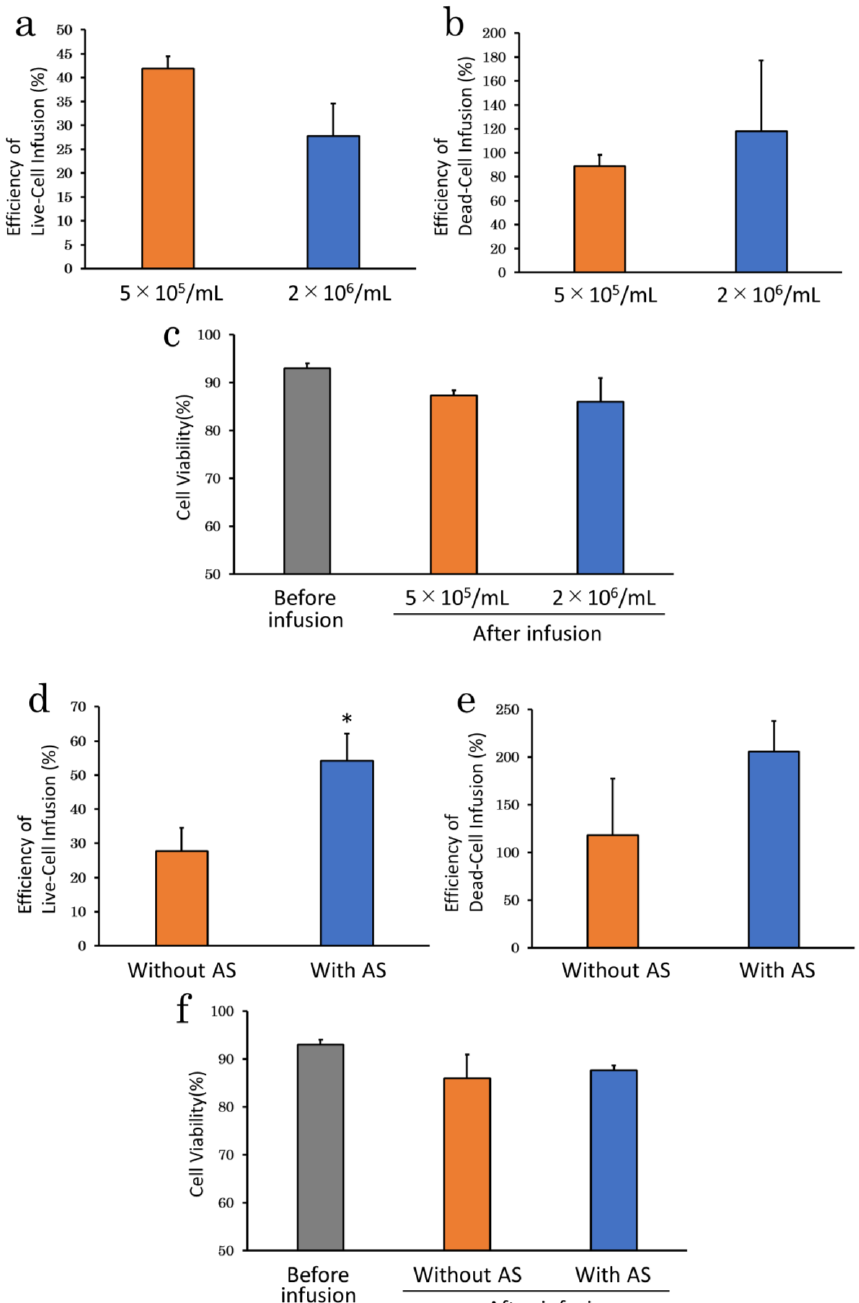
Figure 6. Cell density experiments. ( a ), Efficiency of live-cell infusion at different cell densities. Higher cell density tended to result in lower efficiency of live-cell infusion; ( b ), Efficiency of dead- cell infusion at different cell densities. Higher cell density tended to result in higher efficiency of dead-cell infusion; ( c ), Cell viability at different cell densities. Higher cell density resulted in lower cell viability after infusion; ( d ), Effect of serum supplementation at high cell density. AS supplementation significantly improved efficiency of live-cell infusion at high cell density; ( e ), Effect of serum supplementation on efficiency of live-cell infusion at high cell densities; ( f ), Differences in cell viability after infusion with and without serum supplementation at high cell densities. * p < 0.05 vs. without AS. AS: allogenic